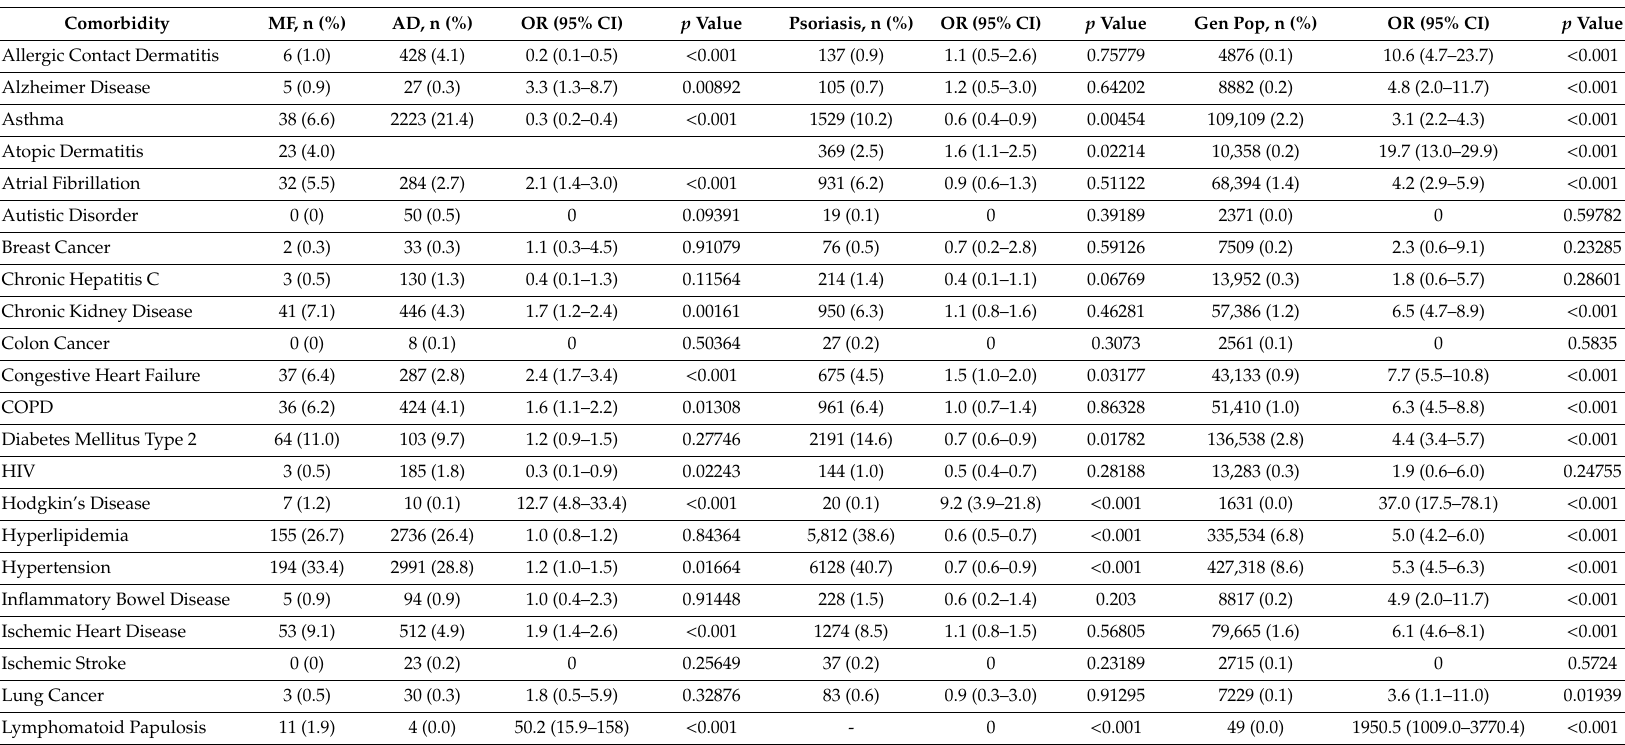
Table A1. Absolute number, percentage, odds ratios and p values of all patients 18 years and older with MF and various comorbid conditions, as compared with those of patients 18 and older with AD, with psoriasis, or within the general population (without MF) who were seen at the Johns Hopkins Hospital System (JHHS) between January 1, 2013 and January 1, 2019. Data presented for 580 patients with mycosis fungoides (MF), 10,382 patients with AD, 15,051 patients with psoriasis, and 4,943,869 patients in the general population (excluding those with MF). AD, Atopic dermatitis; COPD, chronic obstructive pulmonary disease; OR, odds ratio; PN, prurigo